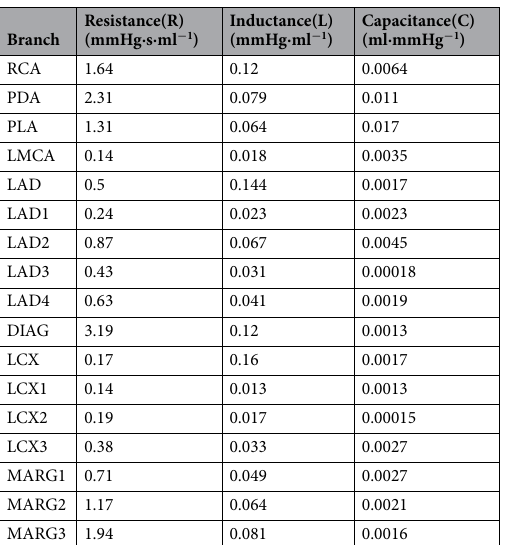
Left ventricle Right ventricle